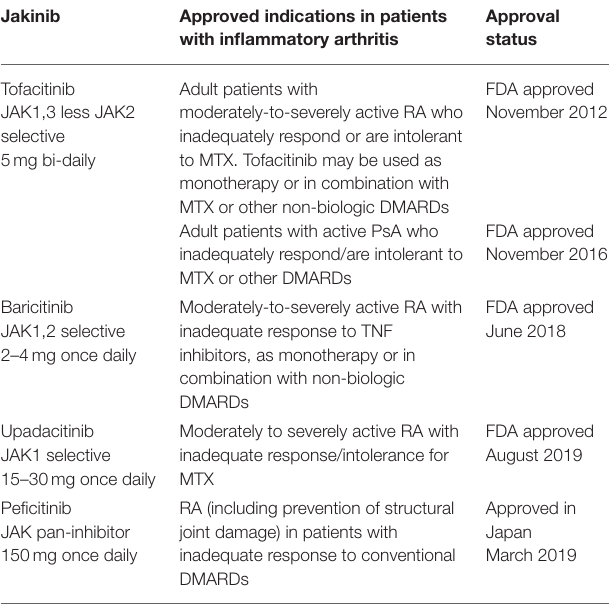
TABLE 1 | FDA-approved jakinibs for the treatment of autoimmune inflammatory